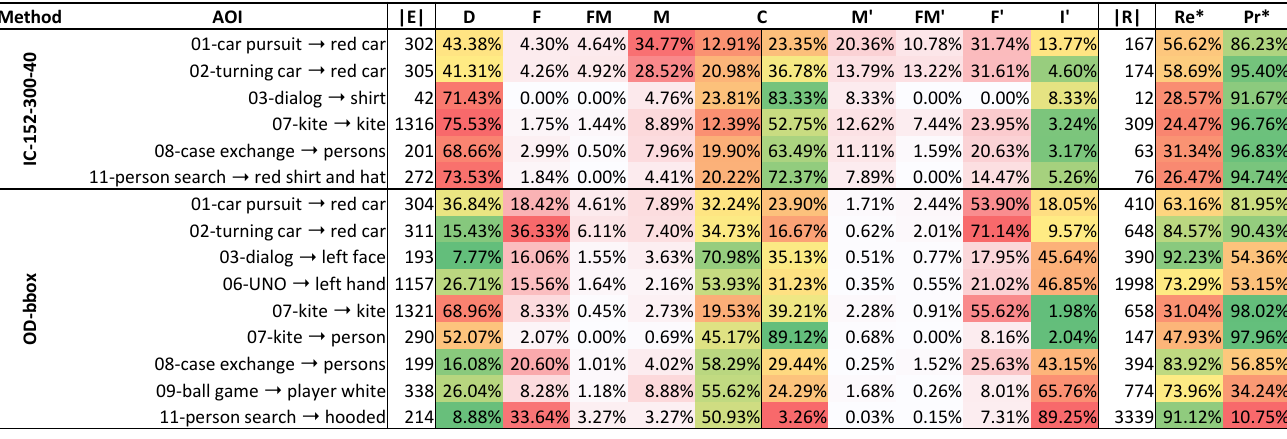
(cid:28) 100%) for IC-152-300-40 and | E |